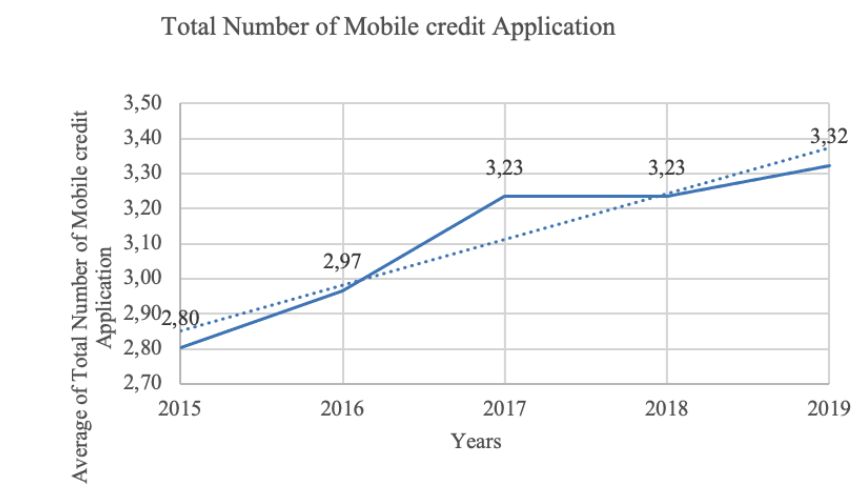
Figure 3: Trend for total number of Total Mobile credit Applications; Source: Survey Data (2021)